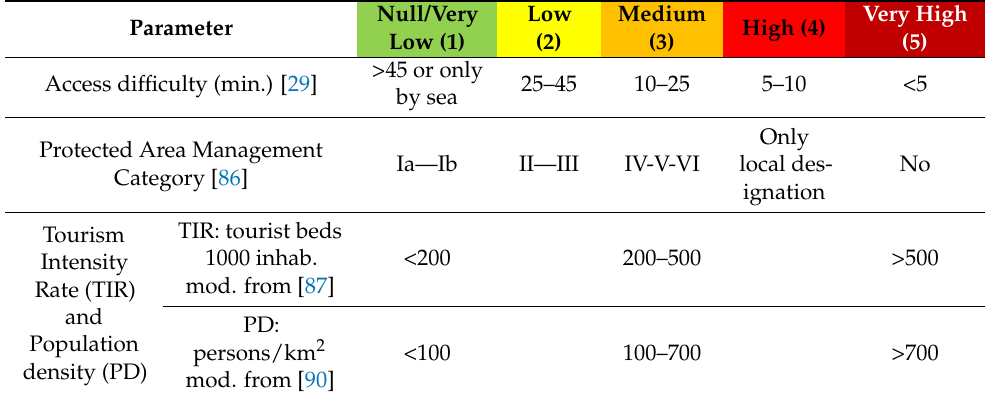
Table 7. Parameters used to assess Human Impact Index.